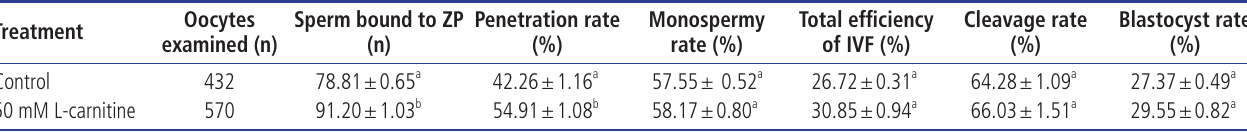
Sperm bound to ZP means sperm binding to the surface of the zona pellucida (n = number of bound spermatozoa per oocyte). The penetration rate means number of oocytes fertilized vs number of inseminated oocytes. The monospermy rate means number of oocytes containing one sperm head-male pronucleus vs number of penetrated oocytes. The total efficiency of fertilization means number of monospermic oocytes vs number of inseminated oocytes. The cleavage rate means the number of 2-cell embryo vs number of zygotes. The blastocyst rate means the number of blastocysts vs number of zygotes. Values are expressed as the mean±standard error of the mean (n = 6). ZP, zona pellucida; IVF, in vitro fertilization. a,b Different letters indicate significant difference at p<0.05 in